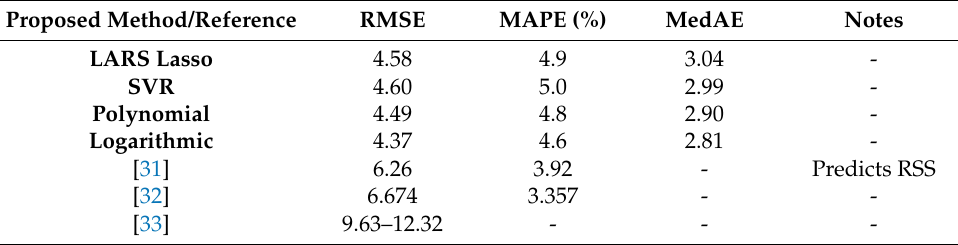
Table 5. Performance of proposed prediction models for RSRP compared against related works.